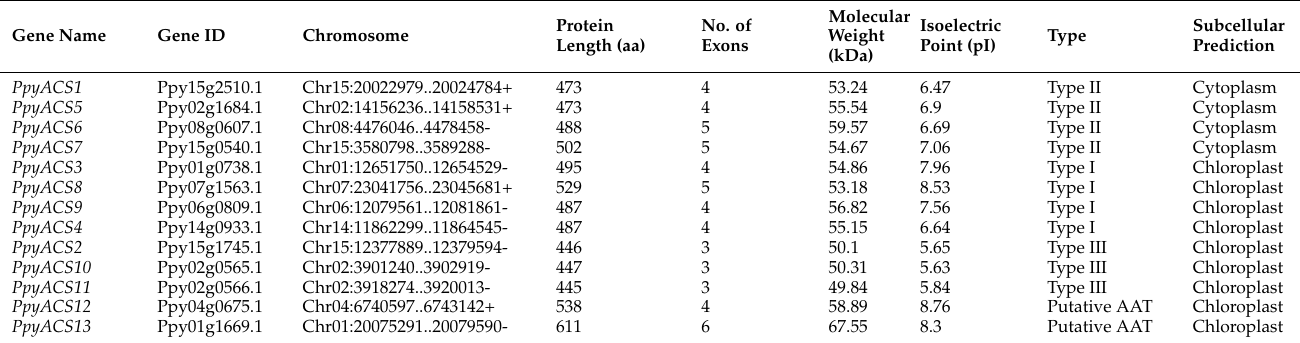
Table 1. Genetic bioinformation of all identified ACS genes in Pyrus pyrifolia